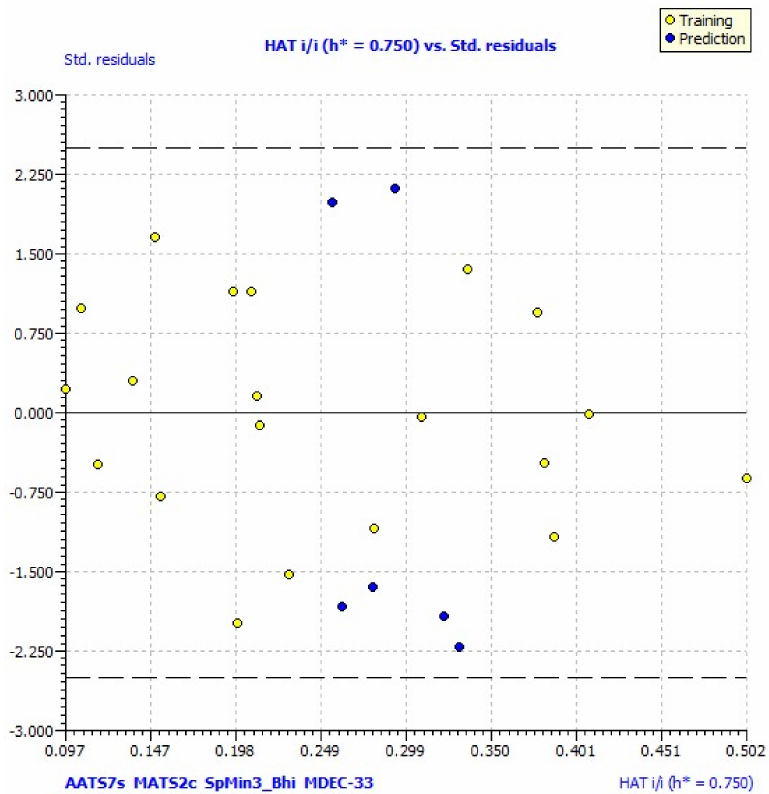
Figure 4. William’s plot of the best model. The dashed lines are the cut-off 3 σ and the warning value of HAT (h*,